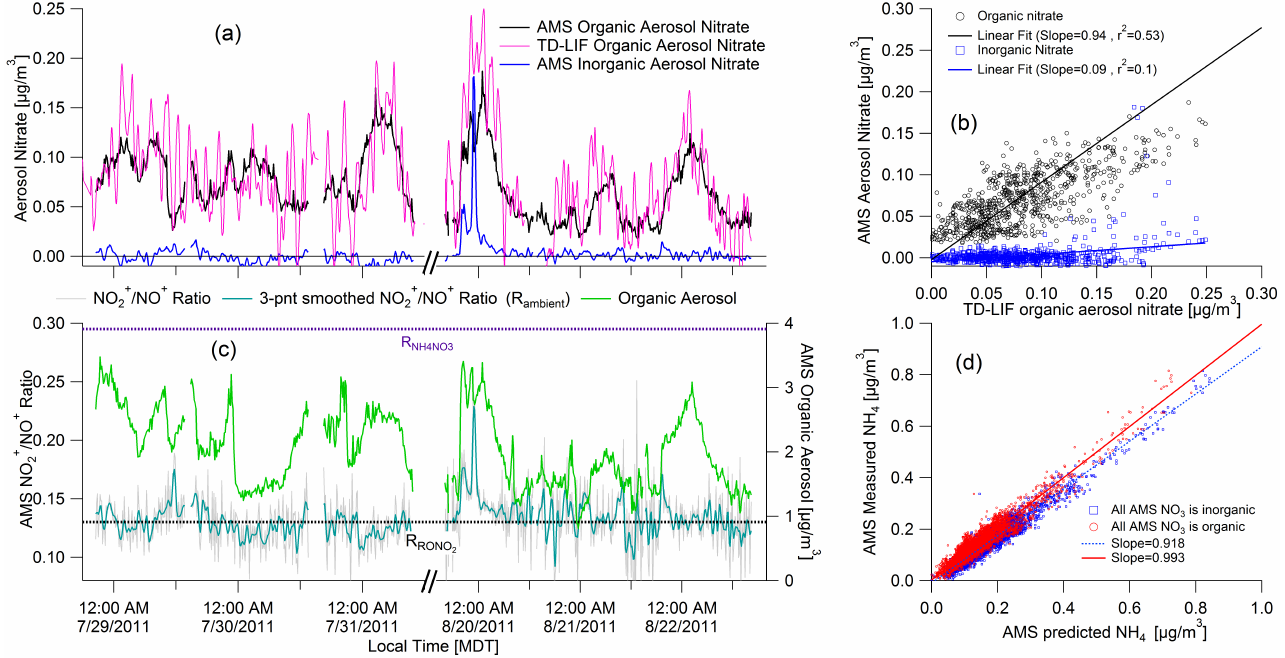
= 0 . 13, / NO + field ratios and R RONO Fig. 11. (a) Concentration of AMS organic and inorganic nitrate, calculated based on the NO + 2 2 compared to aerosol organic nitrate measurements with the TD-LIF system, for the six days the ambient measurements of both instruments overlapped during RoMBAS. (b) Scatter plot of calculated AMS organic and inorganic nitrate with TD-LIF aerosol organic nitrate. (c) Total / NO + ( R ambient ) used to calculate organic nitrate fraction in (a) . Also shown are organic aerosol mass as measured by the AMS, and NO + 2 / NO + ratio determined in calibration with inorganic nitrate as well as the estimated R RONO the NO + ratio. A 3-point smoothed version of 2 2 the ratio was used when calculating RONO 2 . (d) Cation vs. anion balance, evaluated by plotting measured AMS ammonium vs. predicted ammonium for two cases: assuming all AMS nitrate is inorganic and assuming it is all